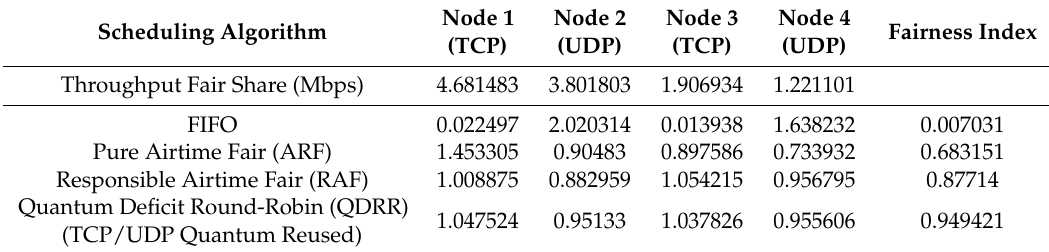
Table 6. Throughput Achievement Ratio and Fairness Index in TCP/UDP Mixed